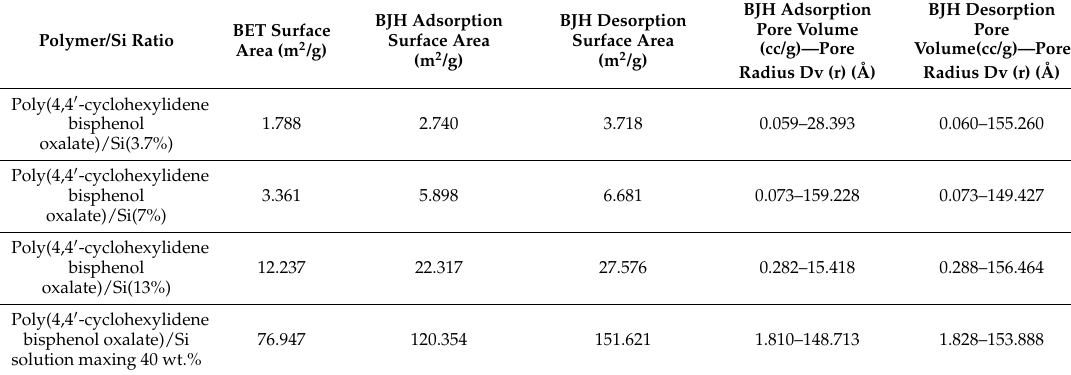
Figure 7. Brunnet–Emmet–Teller (BET) results for poly(4,4’-cyclohexylidene bisphenol oxalate)/Si NCs having wt.% of 3.7%, 7%, 13% and poly(4,4’-cyclohexylidene bisphenol oxalate)/Si solution. Table 5. Comparison of the BET and BJH (Barrett–Joyner–Halenda method) results.